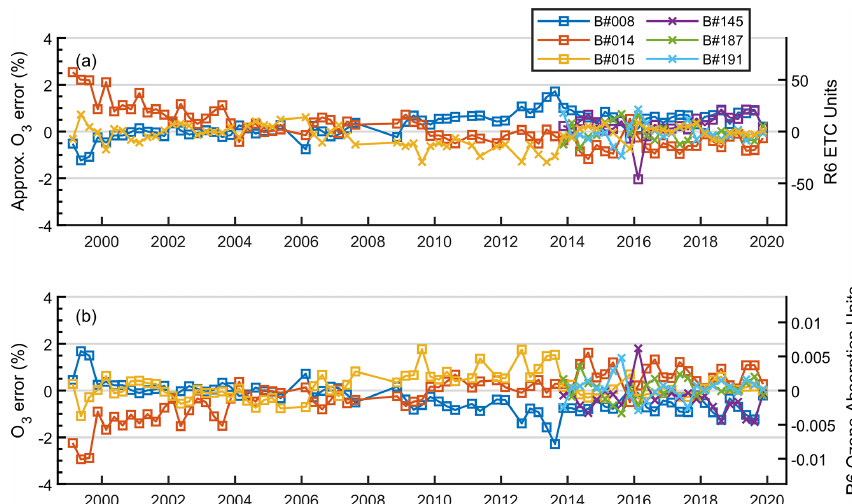
Figure 3. Relative systematic uncertainties in ETCs and effective ozone absorption coefficients estimated using Model 2. The right y axes represent the values in the units used in the actual Brewer algorithm (i.e., R6 ratio units); the left y axes demonstrate the percent values of these errors in total ozone values. Each point on the graph represents a 3-month